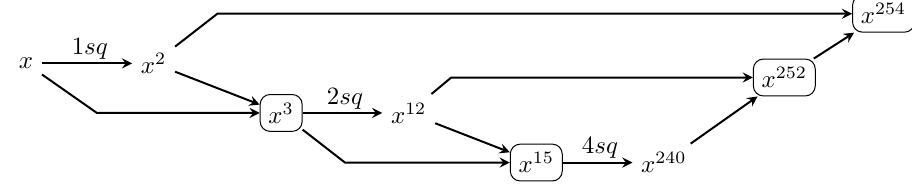
Figure 1: The computation of x 254 used in [RP10]. Monomial with border means that the computation for this monomial is a multiplication, and the number over the arrow represents the number of